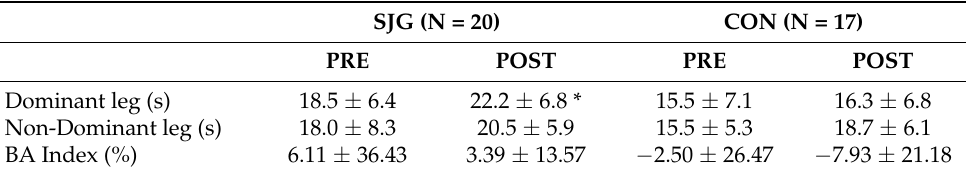
Table 2. Means and standard deviations of Wobble Board performances for dominant and non- dominant leg and SuperJump ® training on the Bilateral Asymmetry Index between testing time by group.